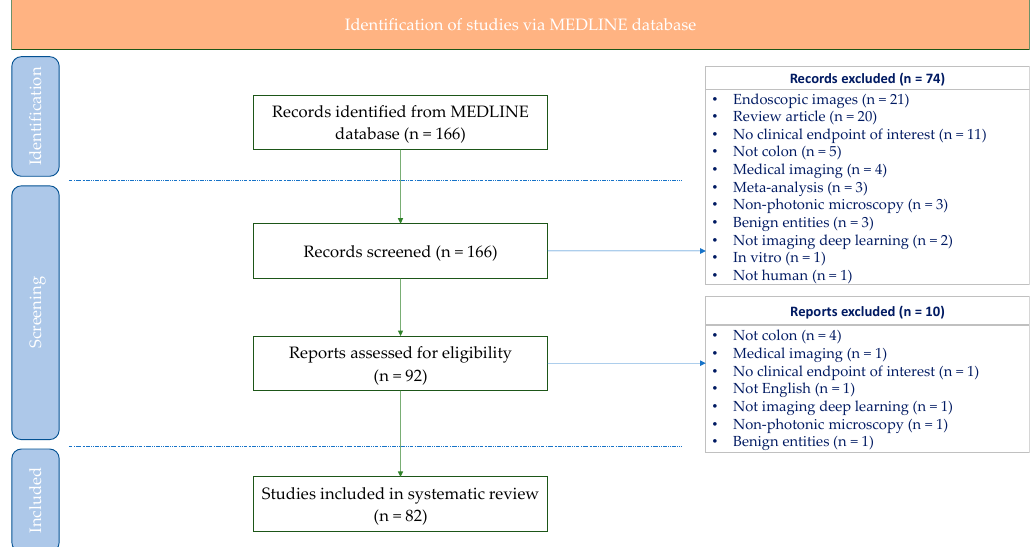
Figure 2. Systematic review flow-chart illustrating systematic search and screening strategy, including number of studies meeting eligibility criteria and number of excluded studies. Last search carried out on 14 January 2022.